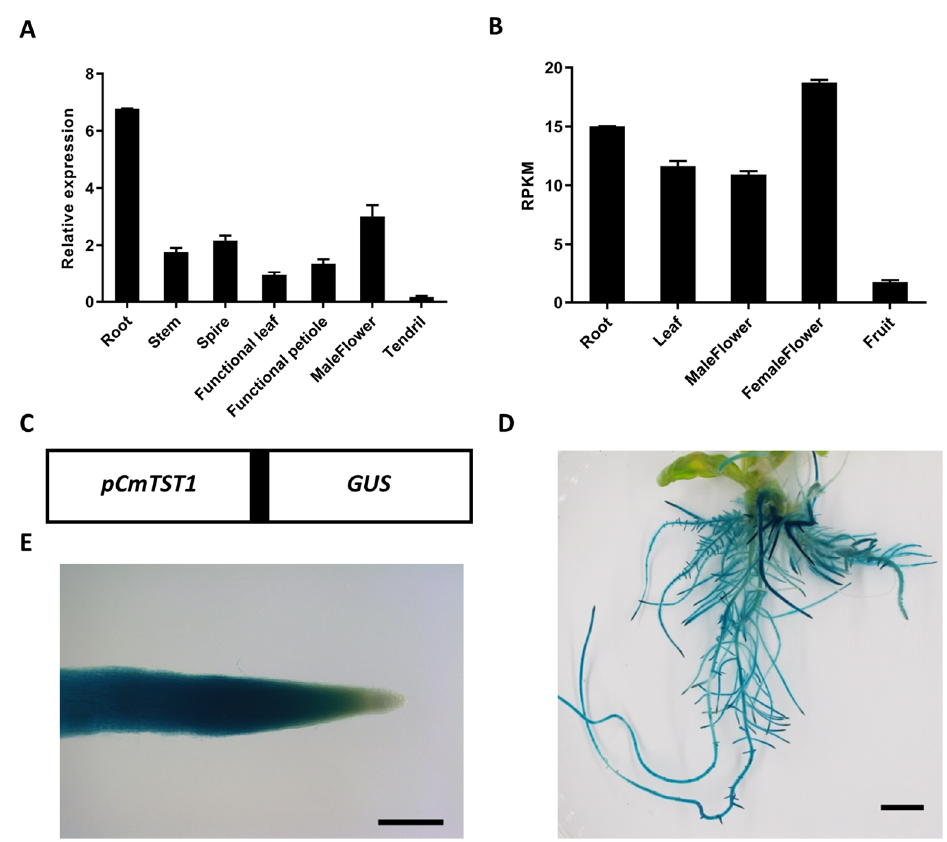
Figure 1. Expression analysis of melon tonoplast sugar transporter gene CmTST1 . (A) qRT-PCR analysis of CmTST1 in “Elizabeth” melon tissues. (B) Expression analysis of CmTST1 according to the transcriptome data. RPKM, reads per kilobase per million mapped reads; Project, PRJNA383830; Data from cucurbitgenomics (http://cucurbitgenomics.org). (C) Diagram of the transcriptional fusion including 2 kb of the 5′ upstream regulatory region of the TST1 gene ( pTST1– 2 kb) fused to the GUS reporter gene that was used to generate the transgenic lines. The corresponding 5′ UTR region is shown as a black box. (D) GUS staining in transiently transgenic in melon seedling roots. (E) Enlarged root of (D) . Bar in (D) = 1 cm, bar in (E) = 250 μm.